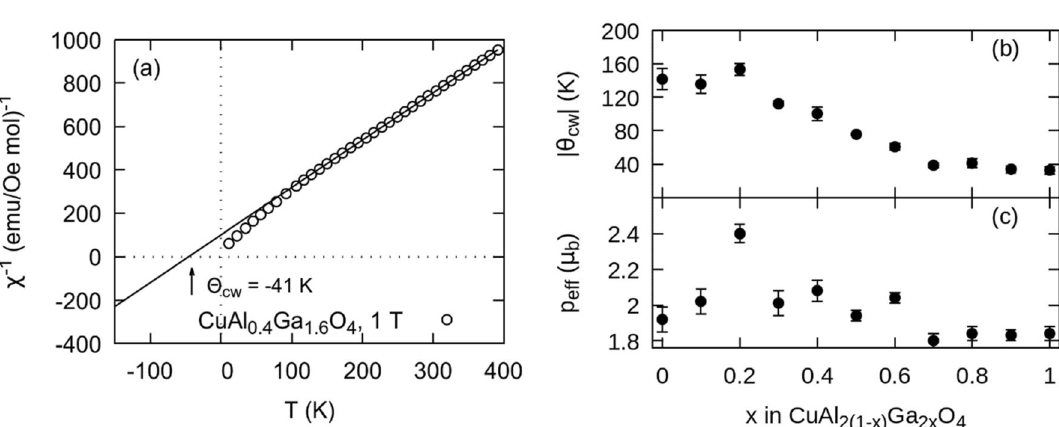
0.8 member of the solid solution; (b) extracted Curie Weiss- =